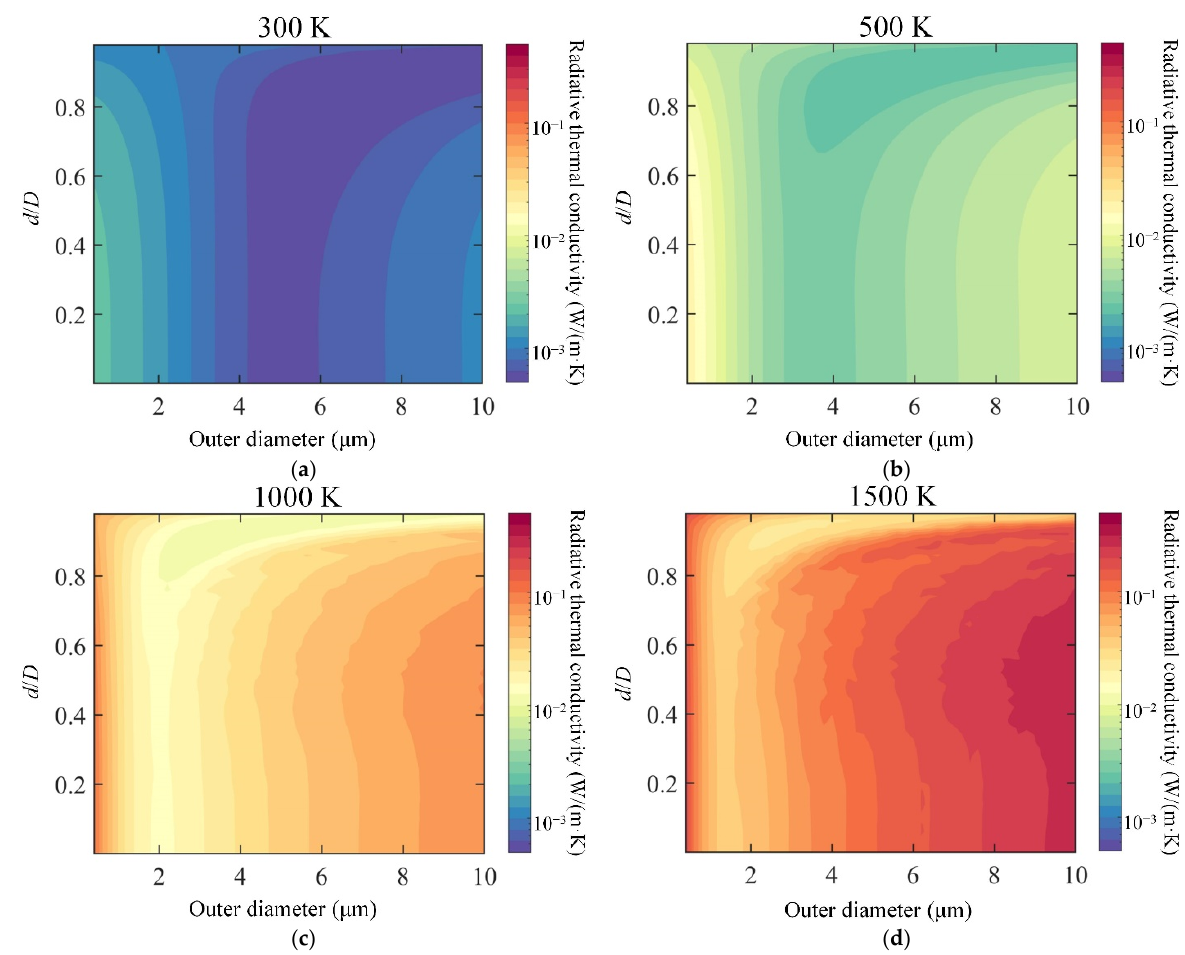
Figure 5. Influence of the shell thickness and outer diameter of hollow opacifiers on the radiative thermal conductivity of silica aerogel composites at a mass fraction of 30%. ( a ) Radiative thermal conductivity of hollow opacifier-doped silica aerogel at 300 K as a function of shell thickness and outer diameter. ( b ) Radiative thermal conductivity of hollow opacifier-doped silica aerogel composite at 500 K as a function of shell thickness and outer diameter. ( c ) Radiative thermal conductivity of hollow opacifier-doped silica aerogel composite at 1000 K as a function of shell thickness and outer diameter. ( d ) Radiative thermal conductivity of hollow opacifier-doped silica aerogel composite at 1500 K as a function of shell thickness and outer diameter.